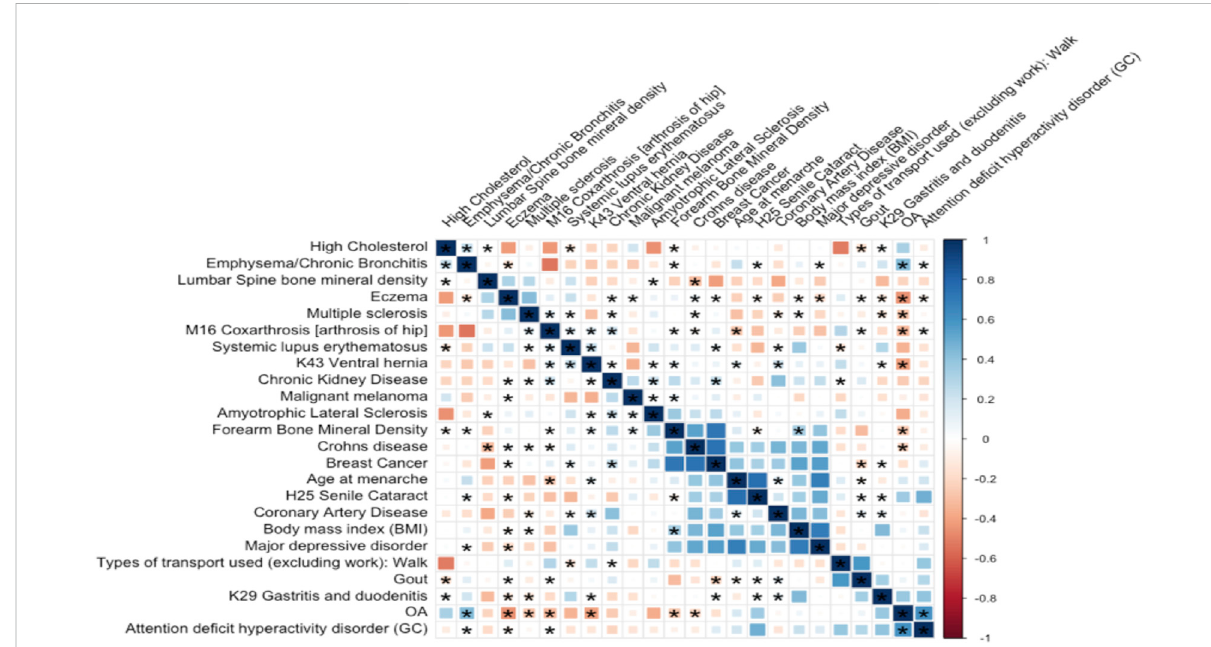
FIGURE 4 Genetic correlation between OA and 23 highly correlated disease traits. The square color corresponds to r g . A positive genetic association is showninblue,whereasanegativegeneticcorrelationisrepresentedbyred.The p -valueisproportionaltothesizeofthecoloredsquares,withlarger squares representing a lower p -value. Asterisks indicate genetic associations that differ from 0 at P <